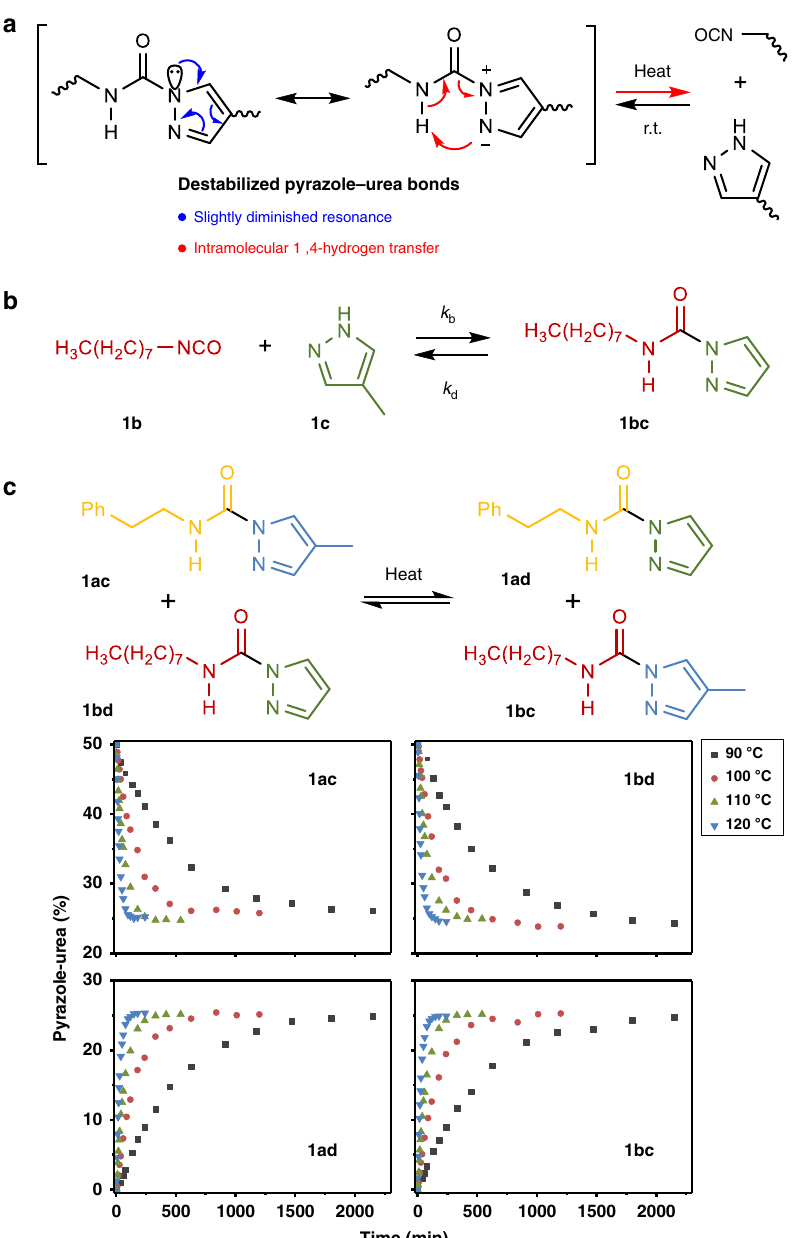
Fig. 1 The dynamic nature of pyrazole – urea bonds. a Destabilized pyrazole – urea bonds through opposed resonance and kinetically favored intramolecular hydrogen transfer. b The association and dissociation of 1bc . c The model exchange reaction of 1ac and 1bd to produce 1ad and 1bc as a function of time upon heating at different temperatures